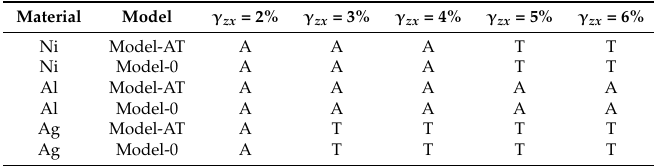
Table 1. Screw dislocation/ISF interaction modes for a variety of materials (Ni, Al, and Ag), models (Model-AT and Model-0), and applied shear strains γ zx (2%~6%). Two modes are observed: annihilation of the ISF (A) and transmission of the screw dislocation across the ISF (T), a common sequence for screw dislocation/ISF interactions with an increasing applied shear strain.